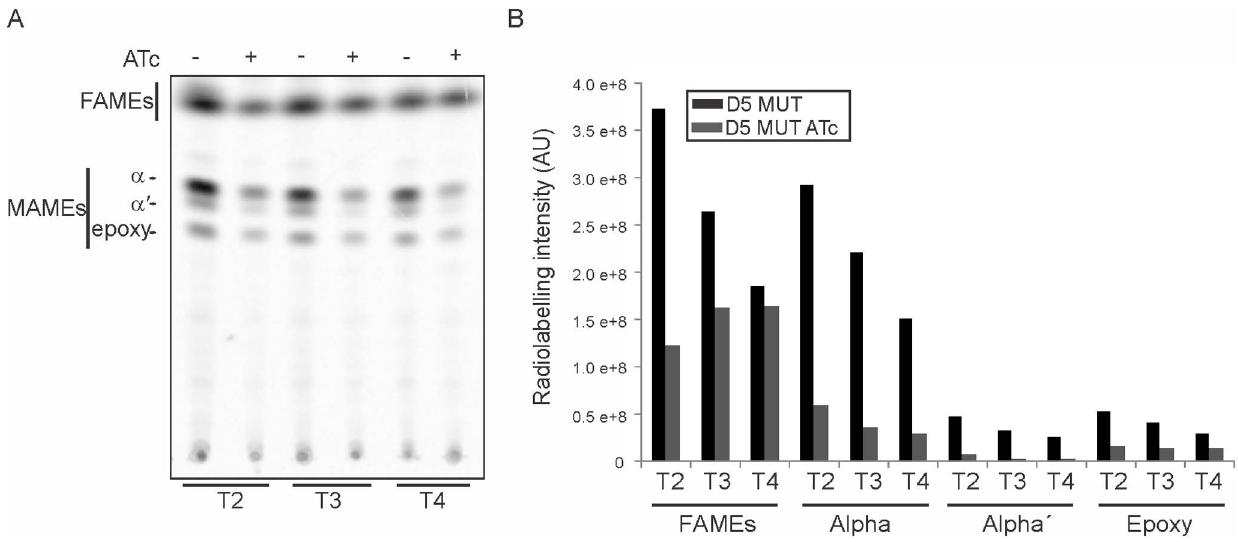
Figure 7. Fatty and mycolic acid profiles in D5 MUT. A) de novo fatty acid and mycolic acid biosyntheses. At the indicated times, aliquots from D5 MUT cultures incubated in absence or presence of ATc were labelled with [ 14 C]-acetate for 1 hour at 37 u C. Fatty acid and mycolic acids methyl esters were extracted from samples containing equivalent amounts of bacteria and were analyzed by TLC. B) Quantification of the radiolabelling intensity of the TLC showed in panel